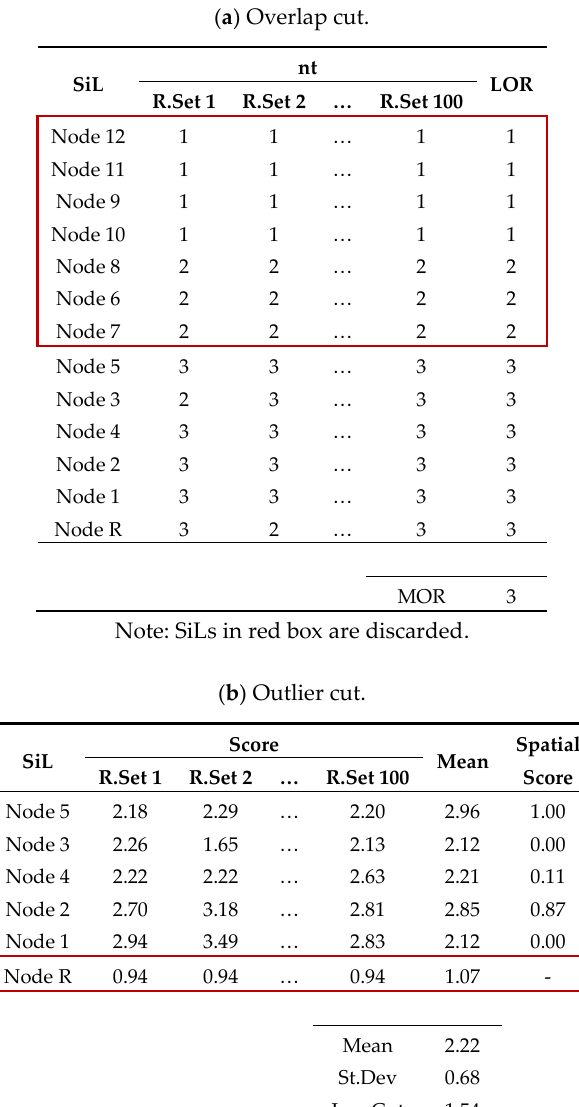
Table 2. Comparison process of the sample network.